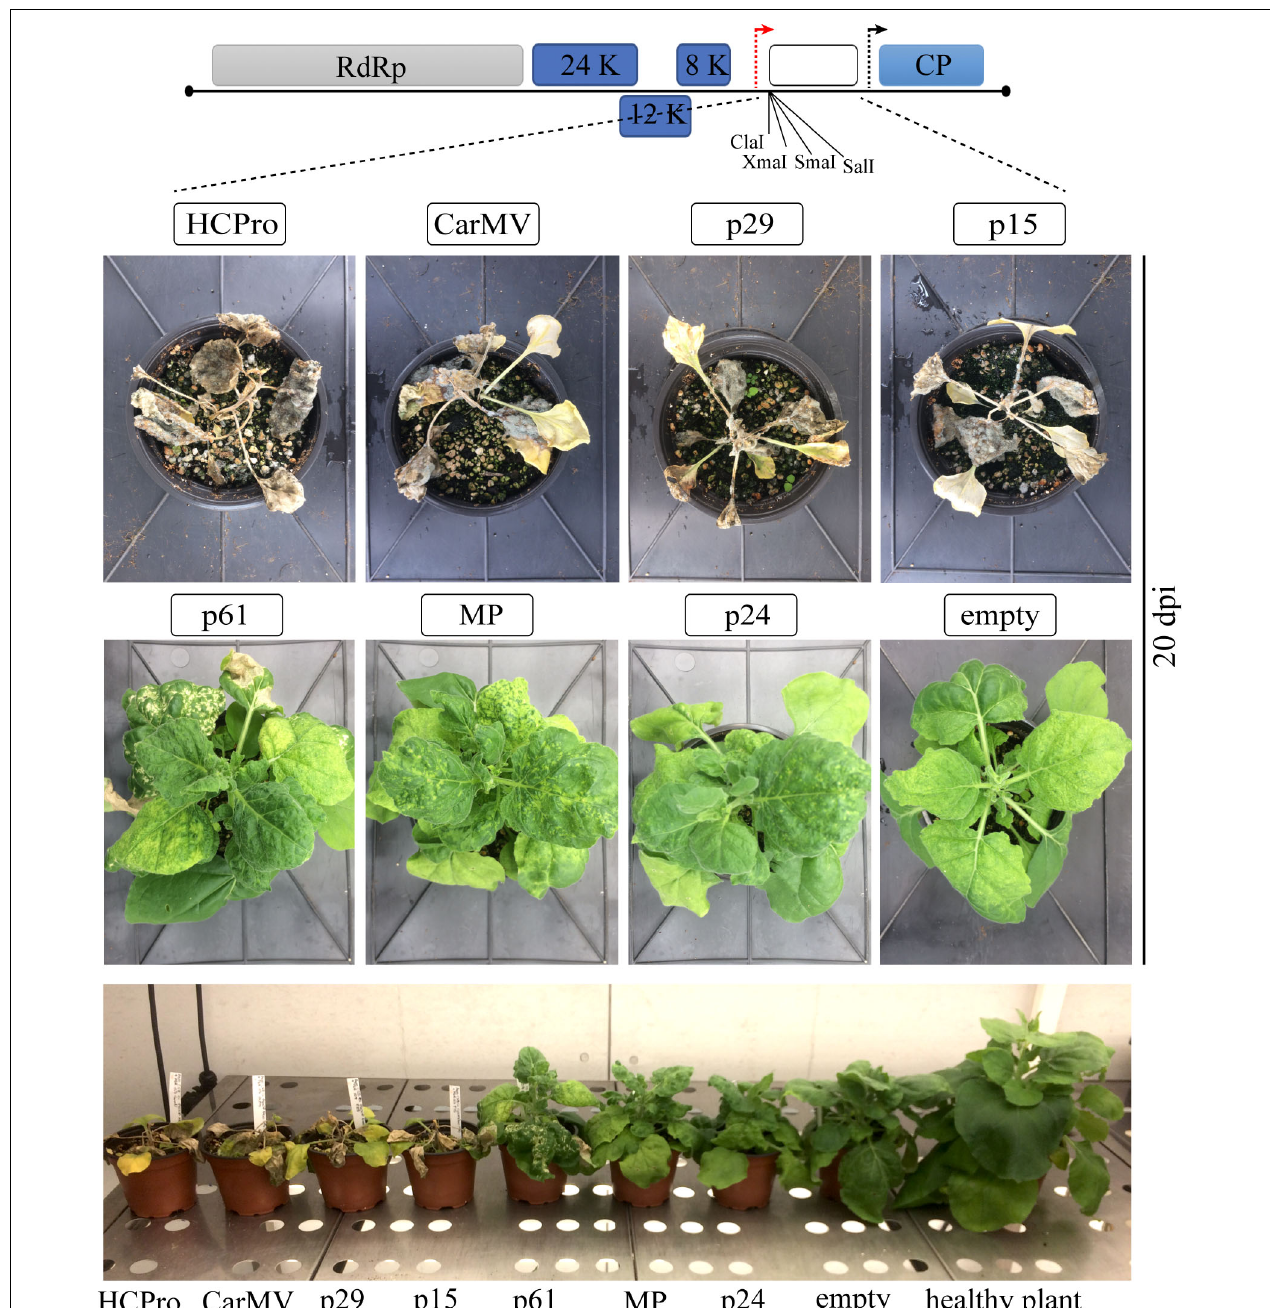
FIGURE 5 | RSS activity of CiLV-C proteins using the potato virus X (PVX) assay. Symptom phenotype of wild type PVX (negative control) and PVX expressing the HCPro, CP CarMV (positive controls), p29, p15, p61, MP, and p24 CiLV-C proteins in N. benthamiana plants at 20 dpi. The schematic representation corresponds the pGR107 PVX infectious construct containing Cla I, Xma I, Sma I, and Sal I sites downstream of the duplicated PVX CP promoter (red arrow), used for the insertion of the indicated viral